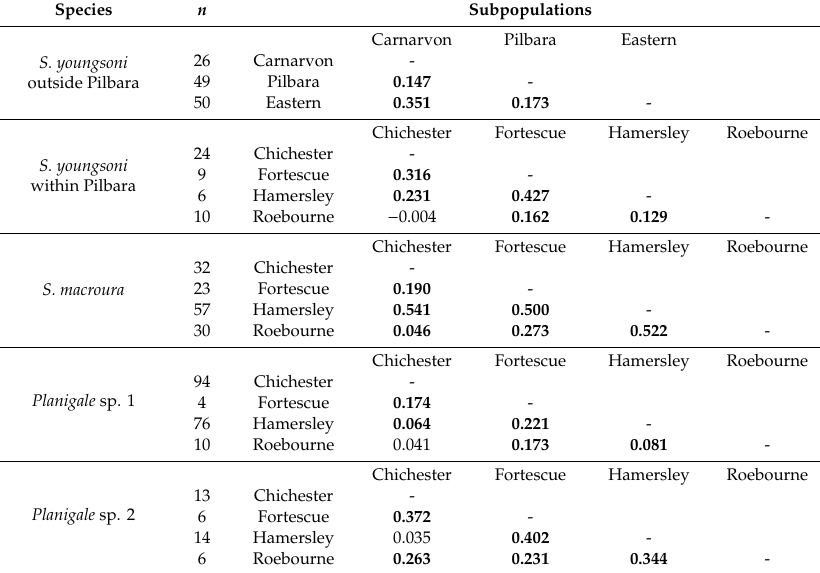
Table 3. Pairwise Φ ST estimates of population di ff erentiation between the Pilbara and other regions of S. youngsoni and within the Pilbara IBRA subregions of S. youngsoni , S. macroura , Planigale sp. 1, and Planigale sp. 2 based on cytb DNA